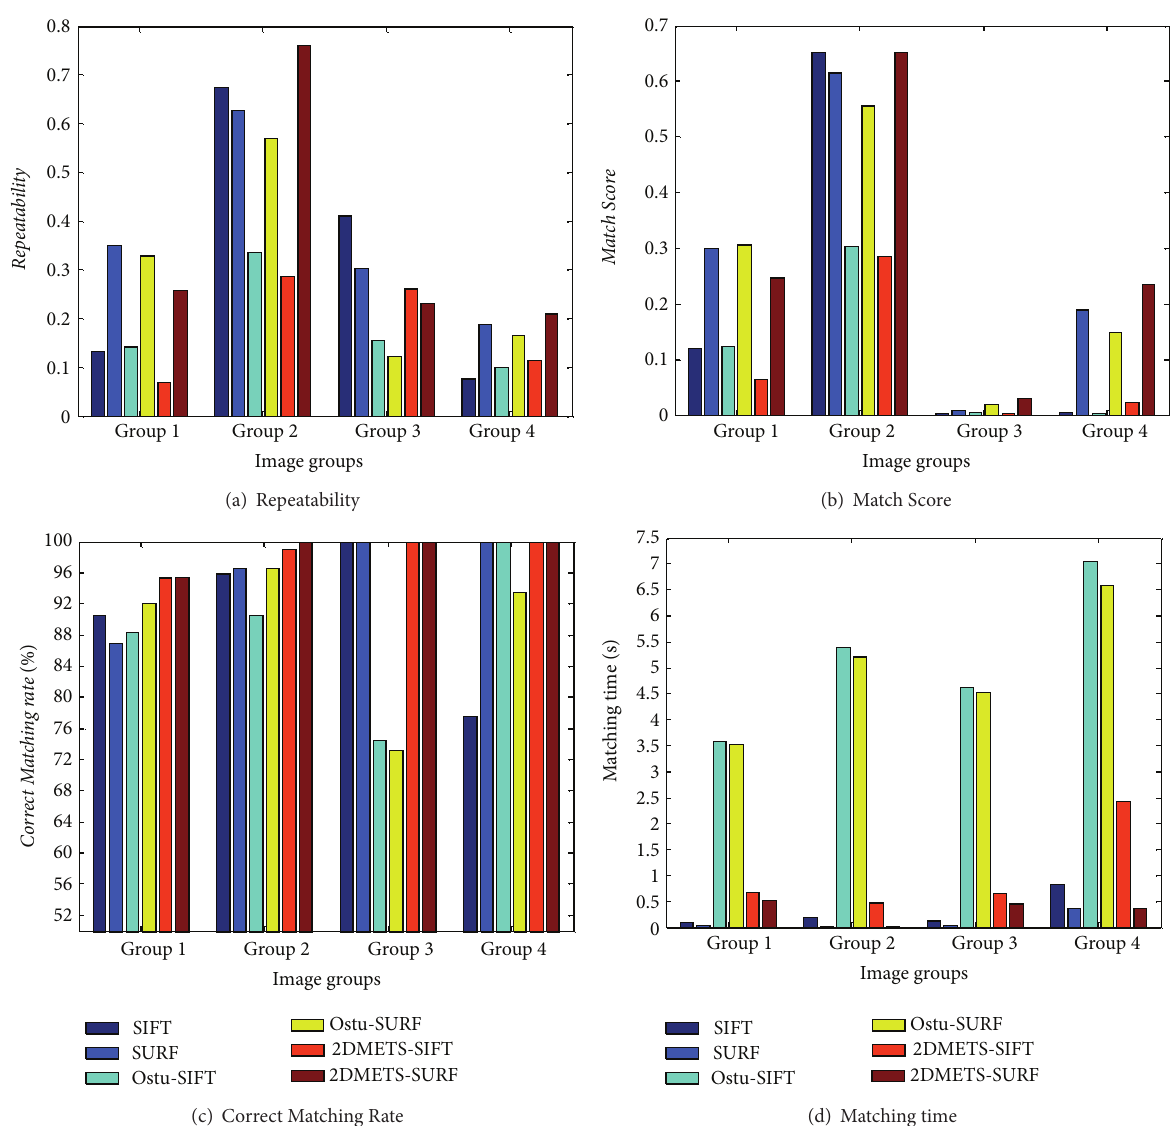
Figure 10: Repeatability, Match Score, Correct Matching Rate , and matching time for each group of